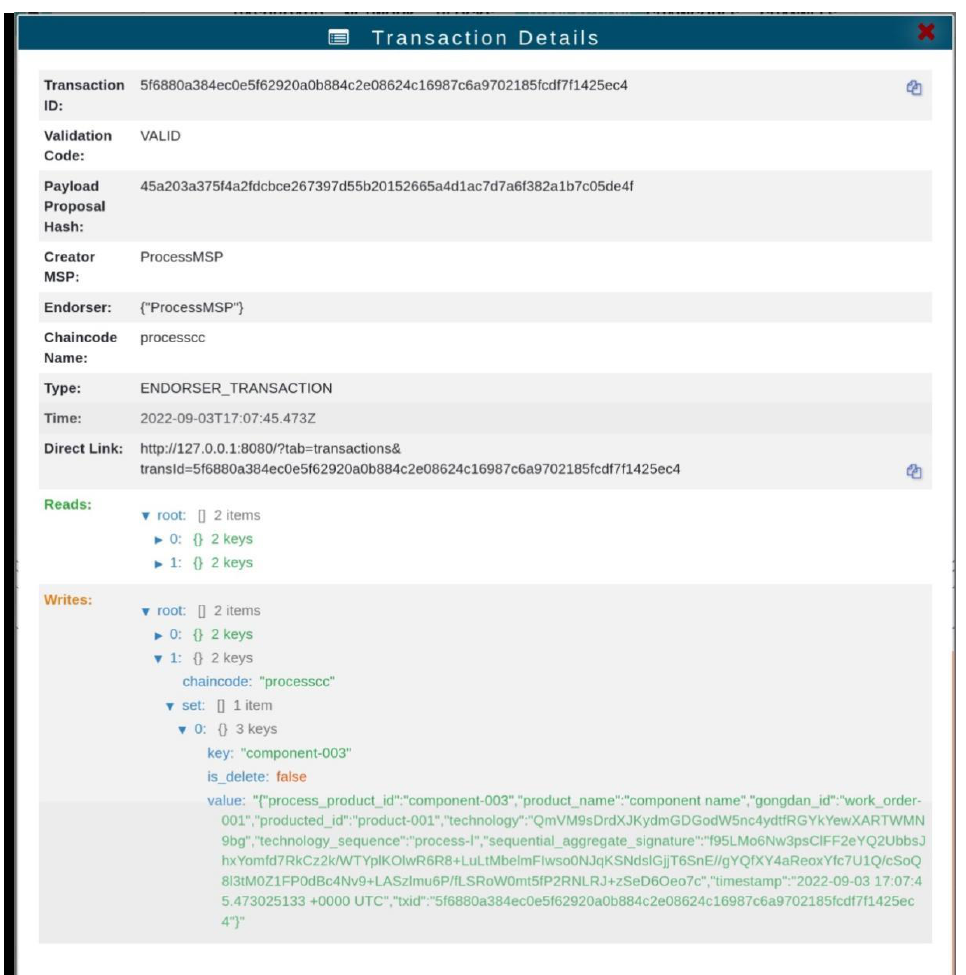
Figure 6. Transaction data generated by production units.